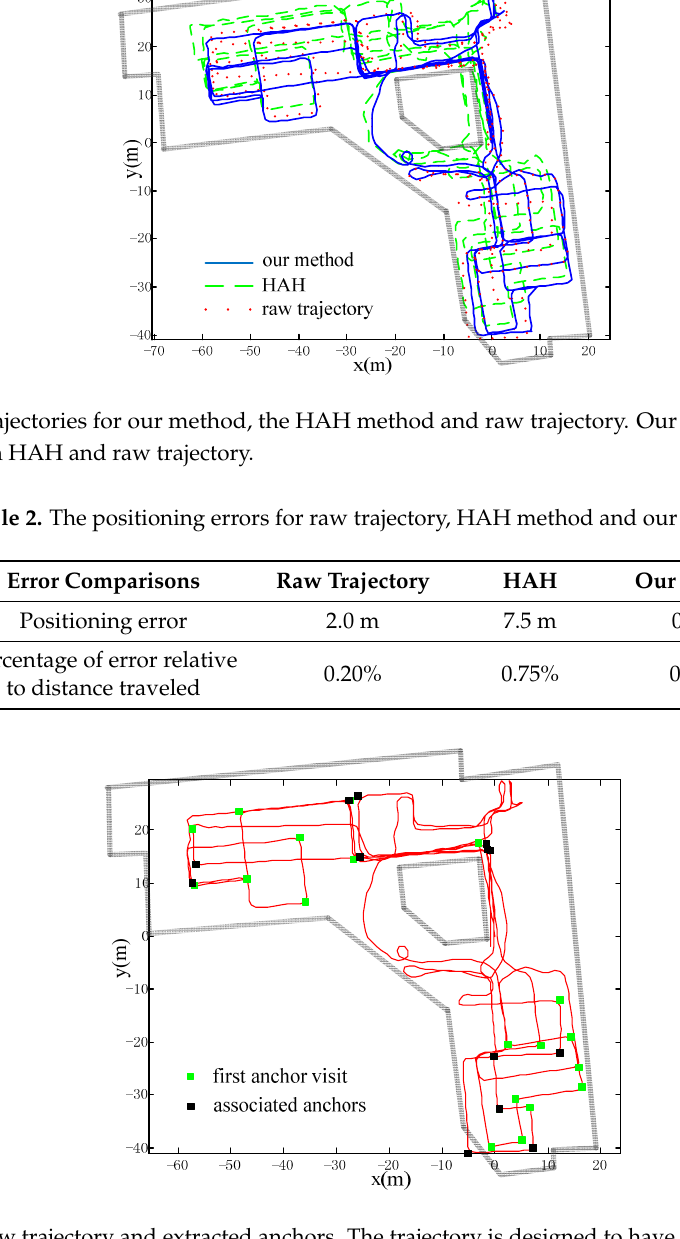
Figure 16. Raw trajectory and extracted anchors. The trajectory is designed to have intensive extracted anchors to test the robustness of the method when wrong anchor association is unavoidable.